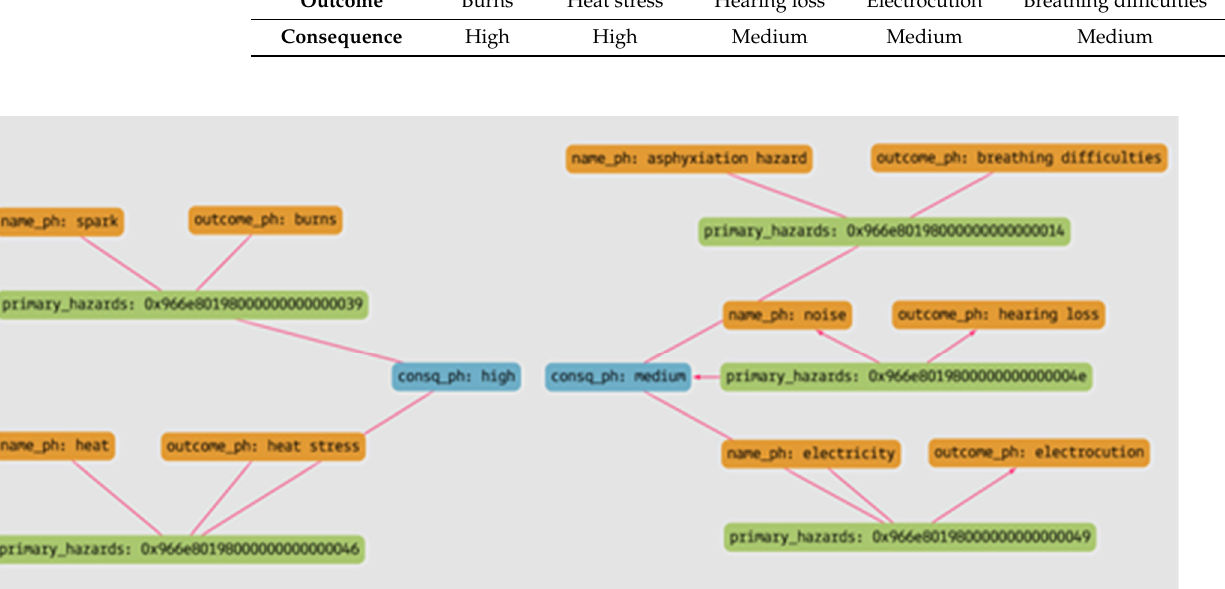
Figure 11. The result of Query 2, in a graph form. Table 6. The result of Query 2, in a tabular form. Hazard